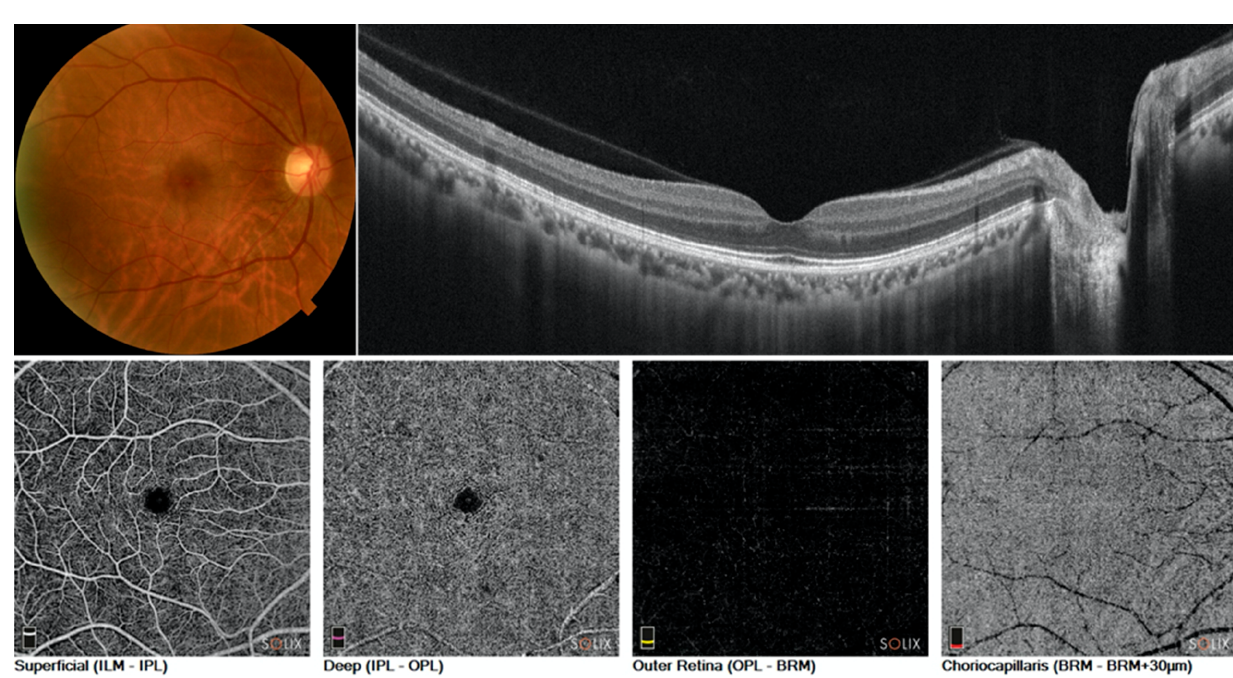
Figure 1. Color fundus photograph ( upper and left ), structural B-scan ( upper and right ), and OCT angiography of superficial, deep, outer, and choriocapillaris ( lower from left to right ) of healthy eye.